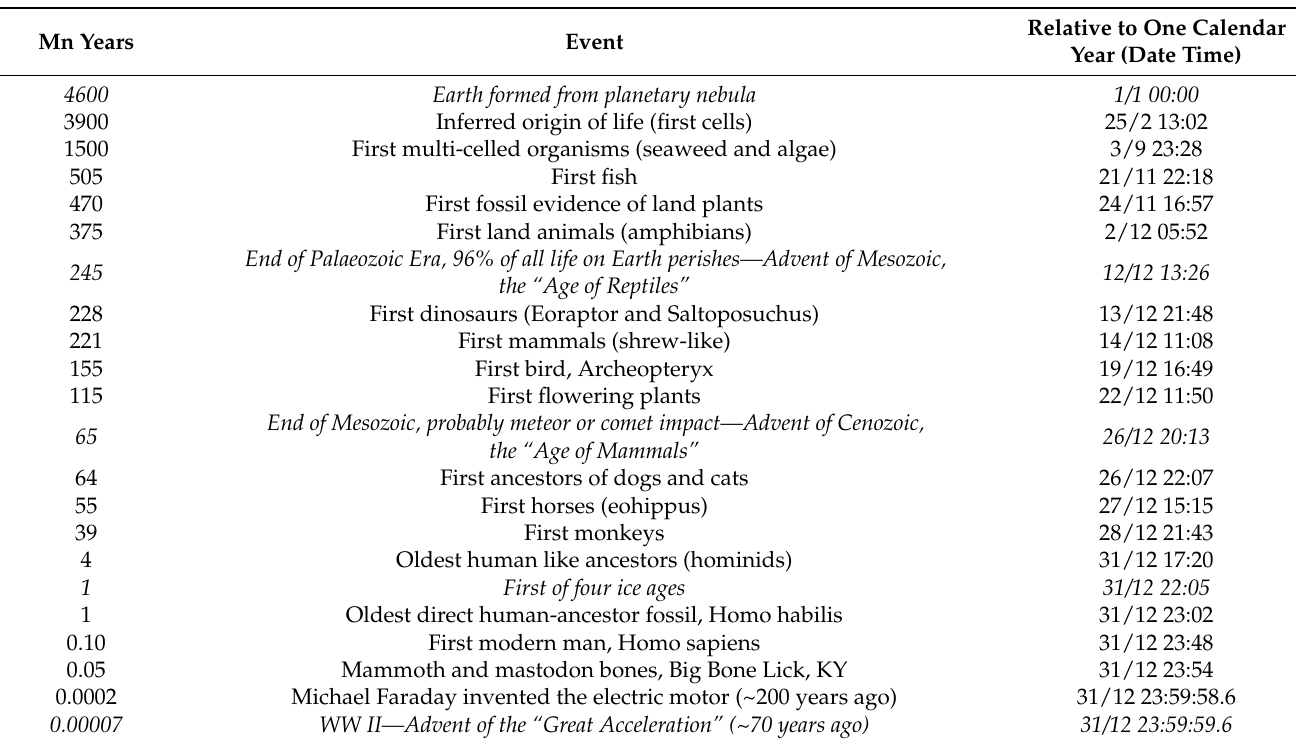
Table 1. Development of life on Earth and selected important events on the scale of one calendar year (1” = ~146 years), adapted from